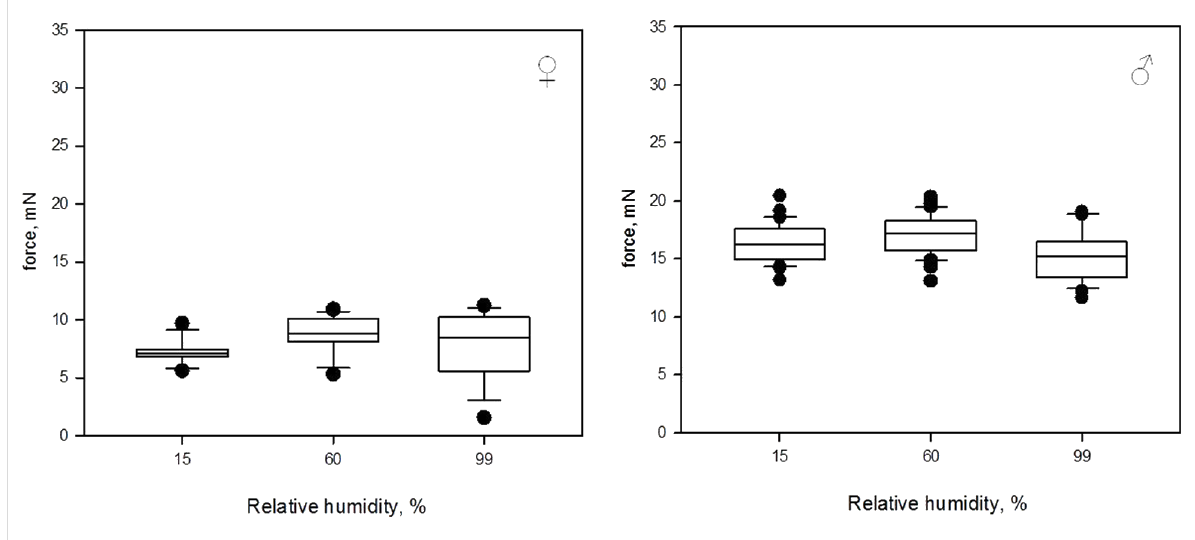
Figure 4: Box-and-whiskers diagrams based on the results of the second experiment with all three levels of RH tested at the same day. The ends of the boxes de fi ne the 25th and 75th percentiles, with a line at the median and error bars de fi ning the 10th and 90th percentiles, black dots represent the